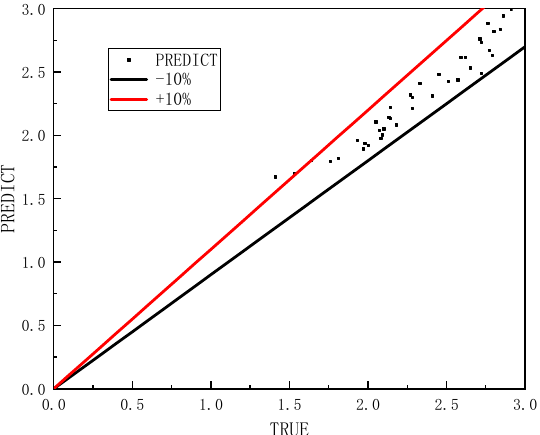
Figure 29. Comparison between predicted and calculated results